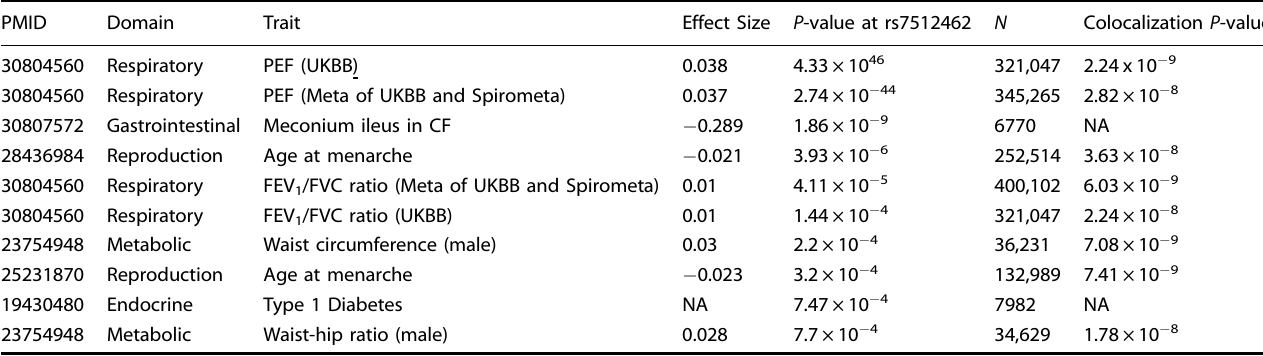
Table 6. The 10 phenotypes with smallest rs7512462 association p-value obtained from the GWAS ATLAS 44